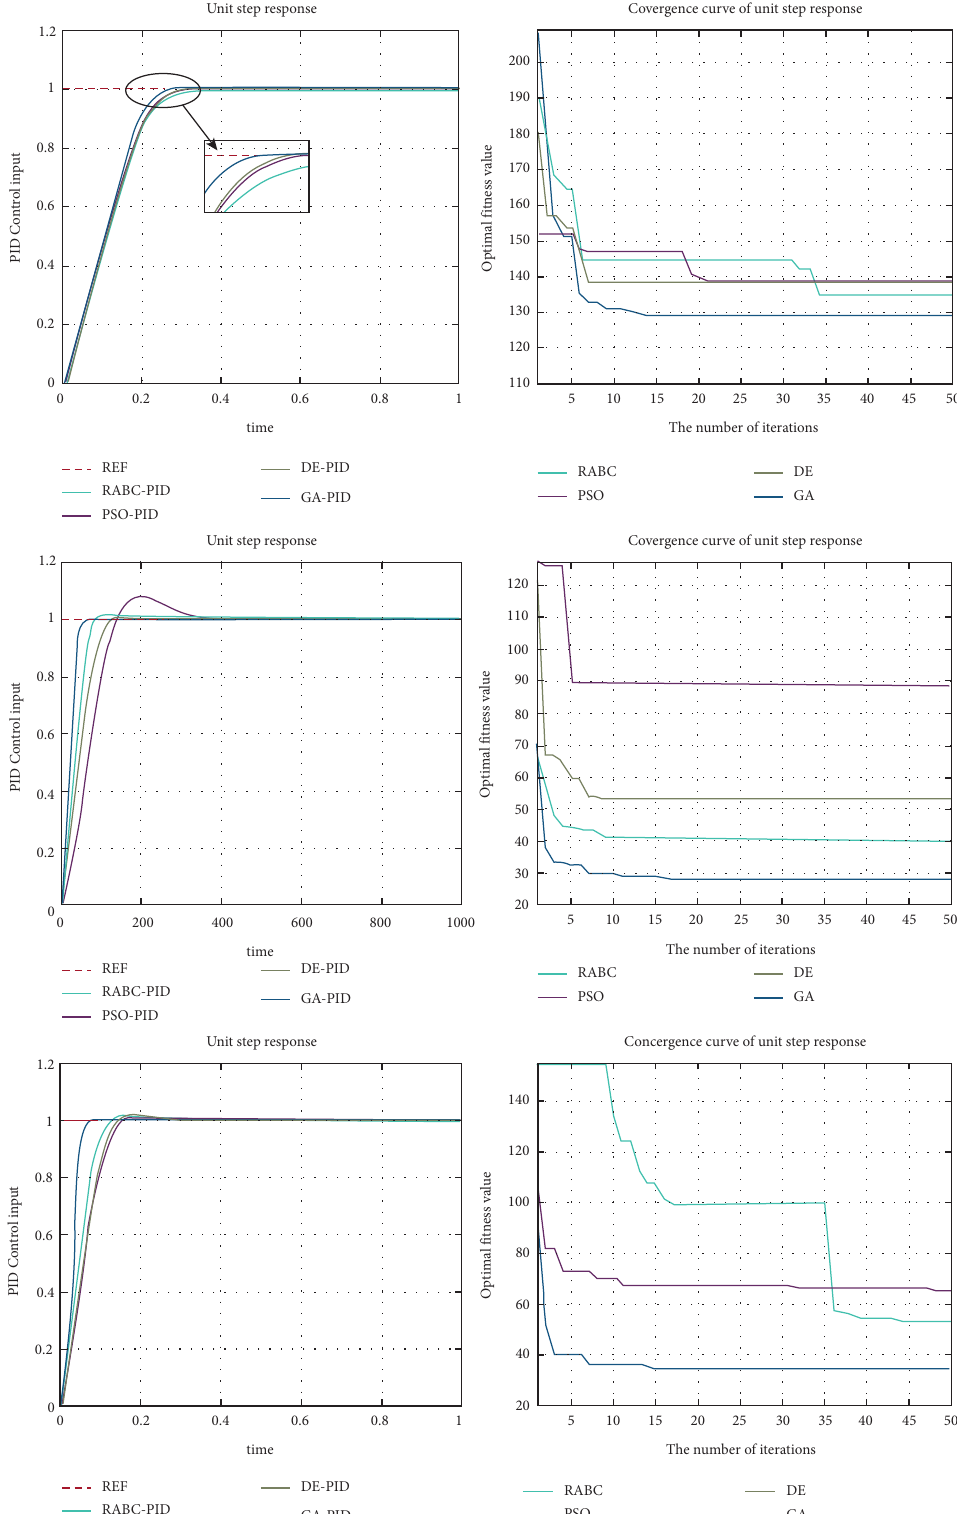
Figure 8: Unit step response curve and convergence curve when the parameters T � 10, T